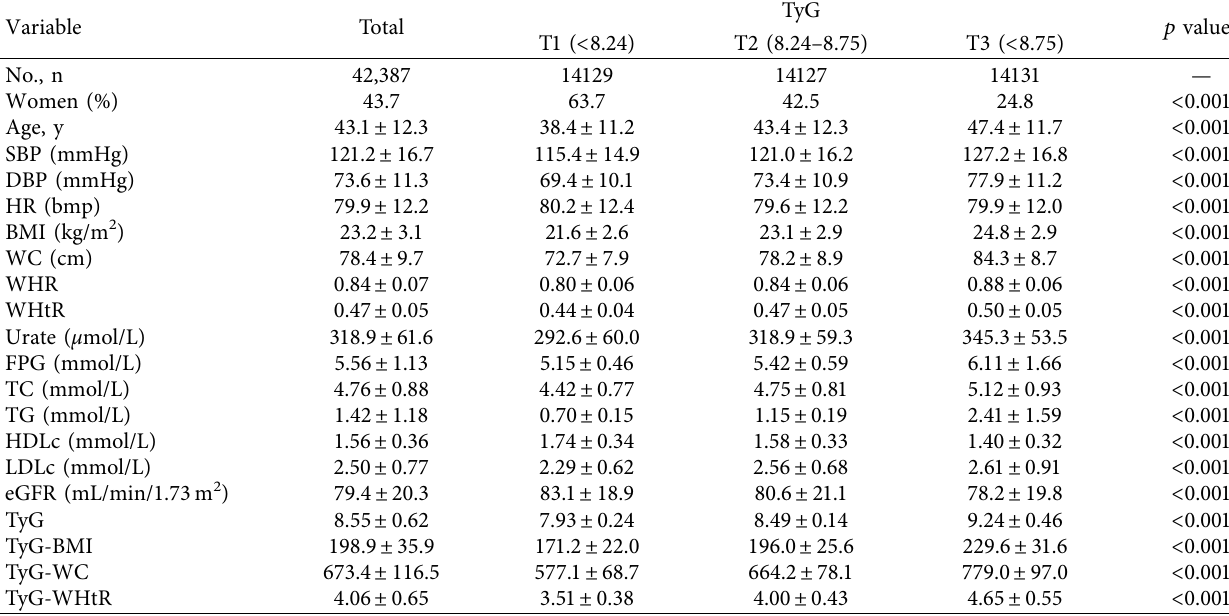
Table 1: Baseline characteristics of subjects grouped according to the tertiles of TyG.